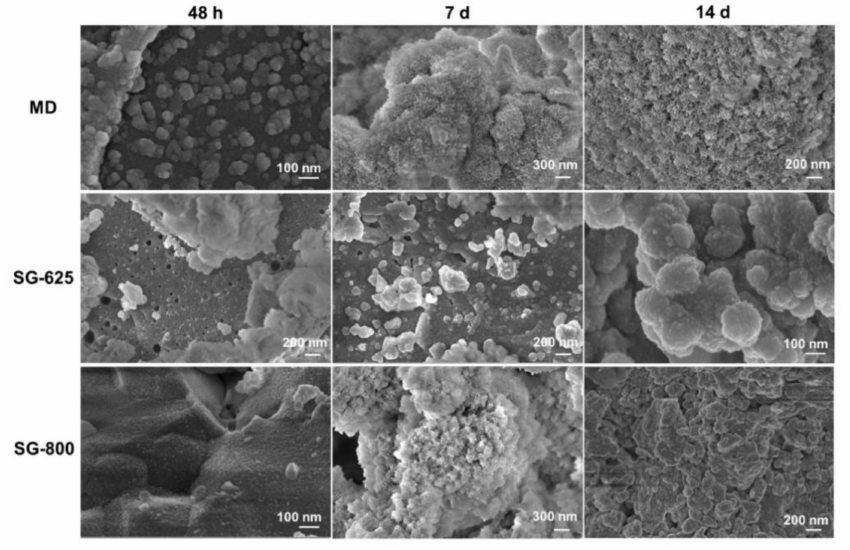
Figure 7. In vitro bioactivity tests: SEM analysis showing the surface evolution at di ff erent immersion time periods in